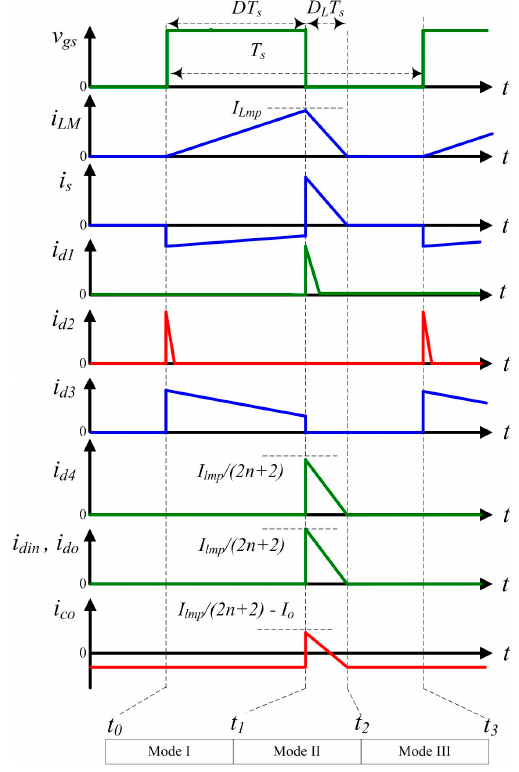
Figure 5. Key components current and voltage waveforms of the proposed converter at DCM operation.